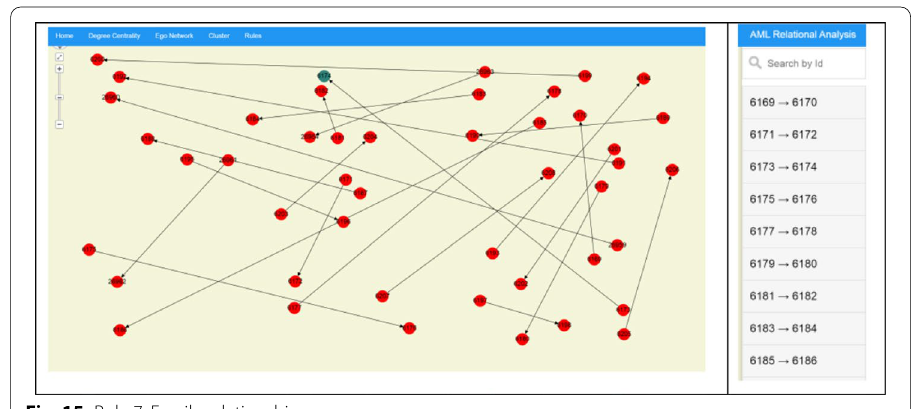
Fig. 15 Rule 7: Family